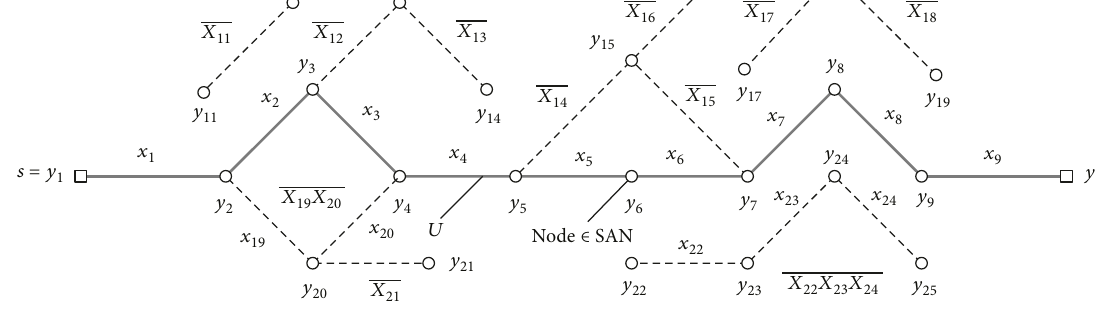
⋯ X ⋯ X 1 X 2 9 X 11 X 12 18 X 19 X 20 X 21 X 22 X 23 X 24 .